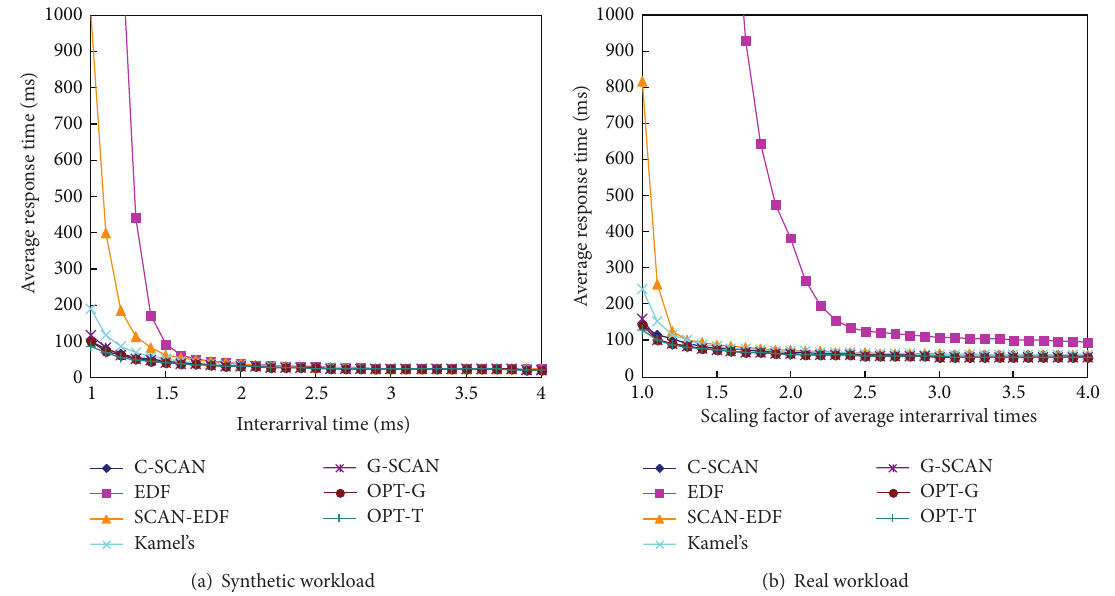
Figure 8: Average response time of the algorithms as a function of workload intensities.